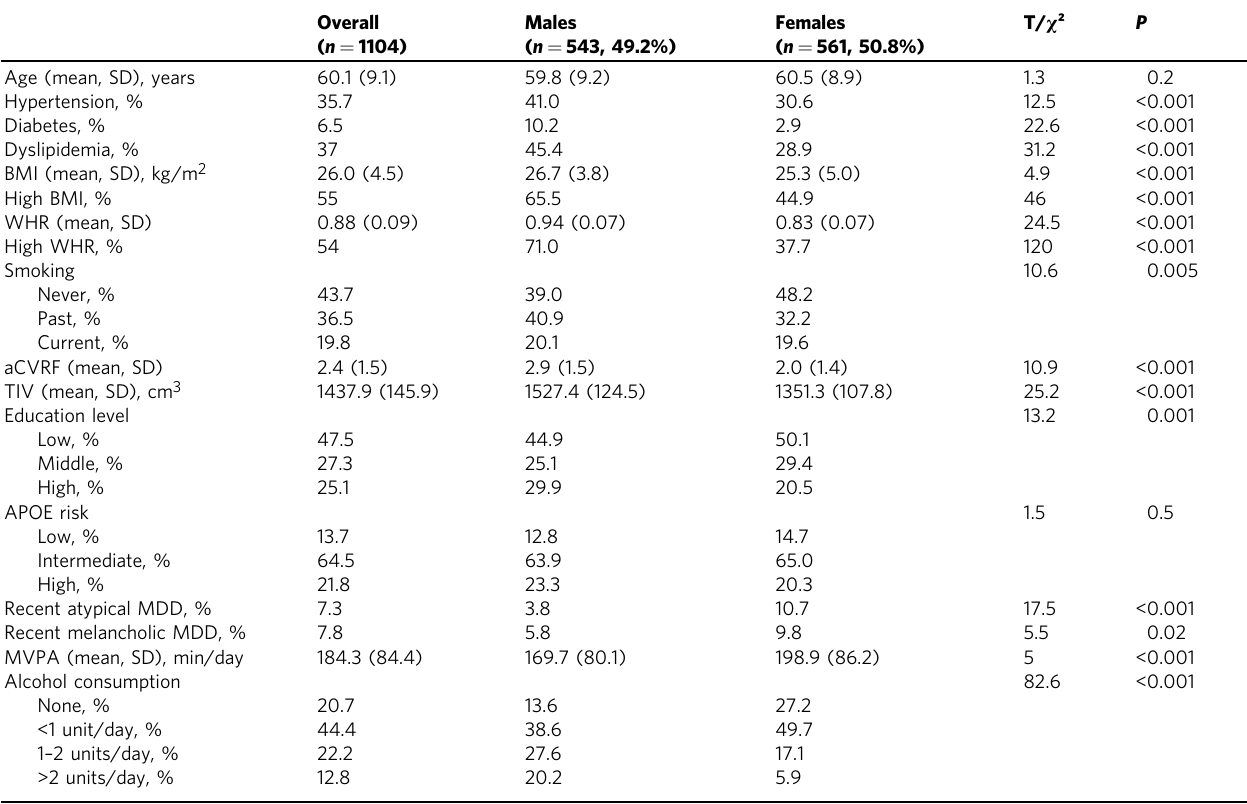
Table 1 Participant characteristics for the whole sample and for males and females separately.